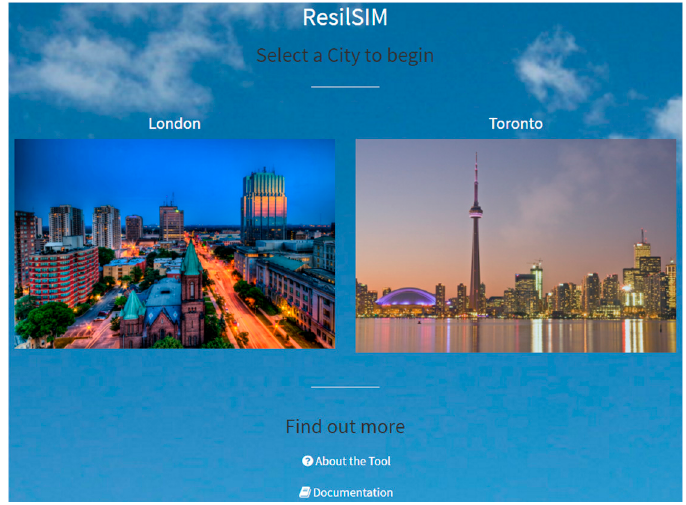
Figure 13. Selection of the urban system (London or Toronto, Ontario, Canada).